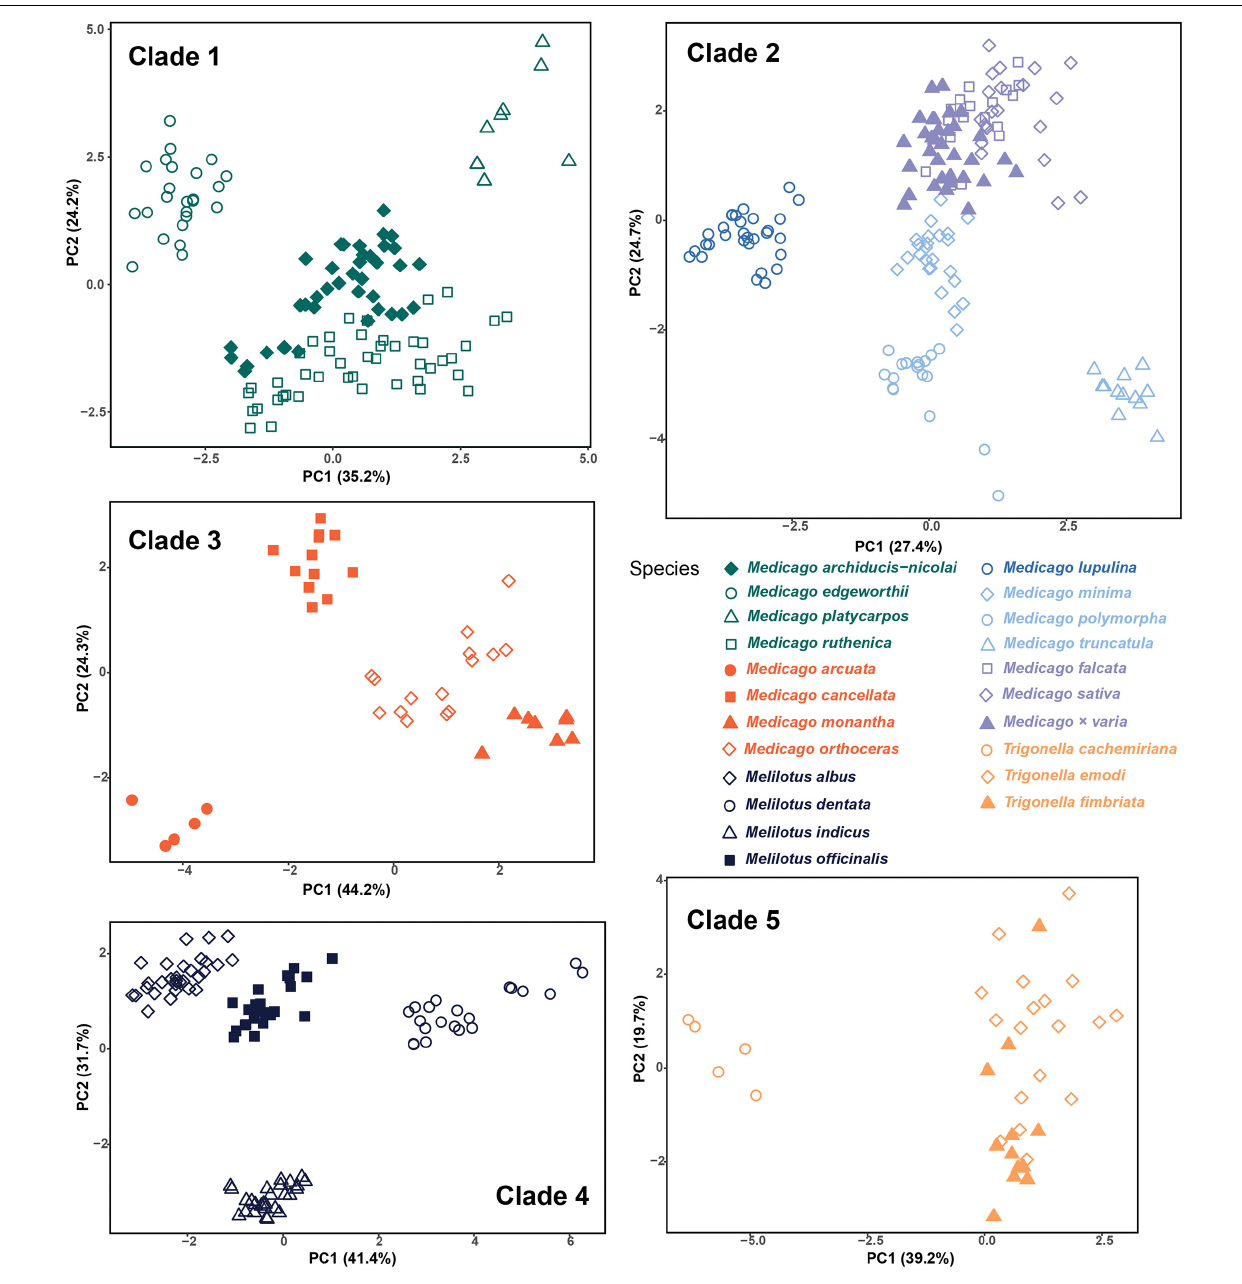
FIGURE 3 | Morphological clustering within each of the five clades inferred from cpDNA phylogenetic tree based on the principal component analysis. Colors are the same as in Figure 2